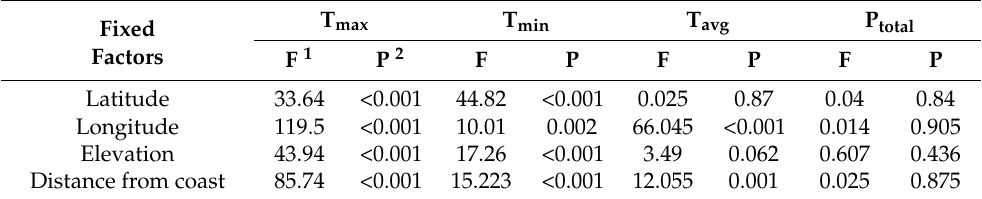
Table 3. Generalized linear model (GLM) analysis between climate variables (T max , T min , T avg, P total ) and geographic factors (Latitude, Longitude, Elevation, Distance from the coast) at the studied 26 wild blueberry fields of Downeast, Maine over 40 years from 1980 to